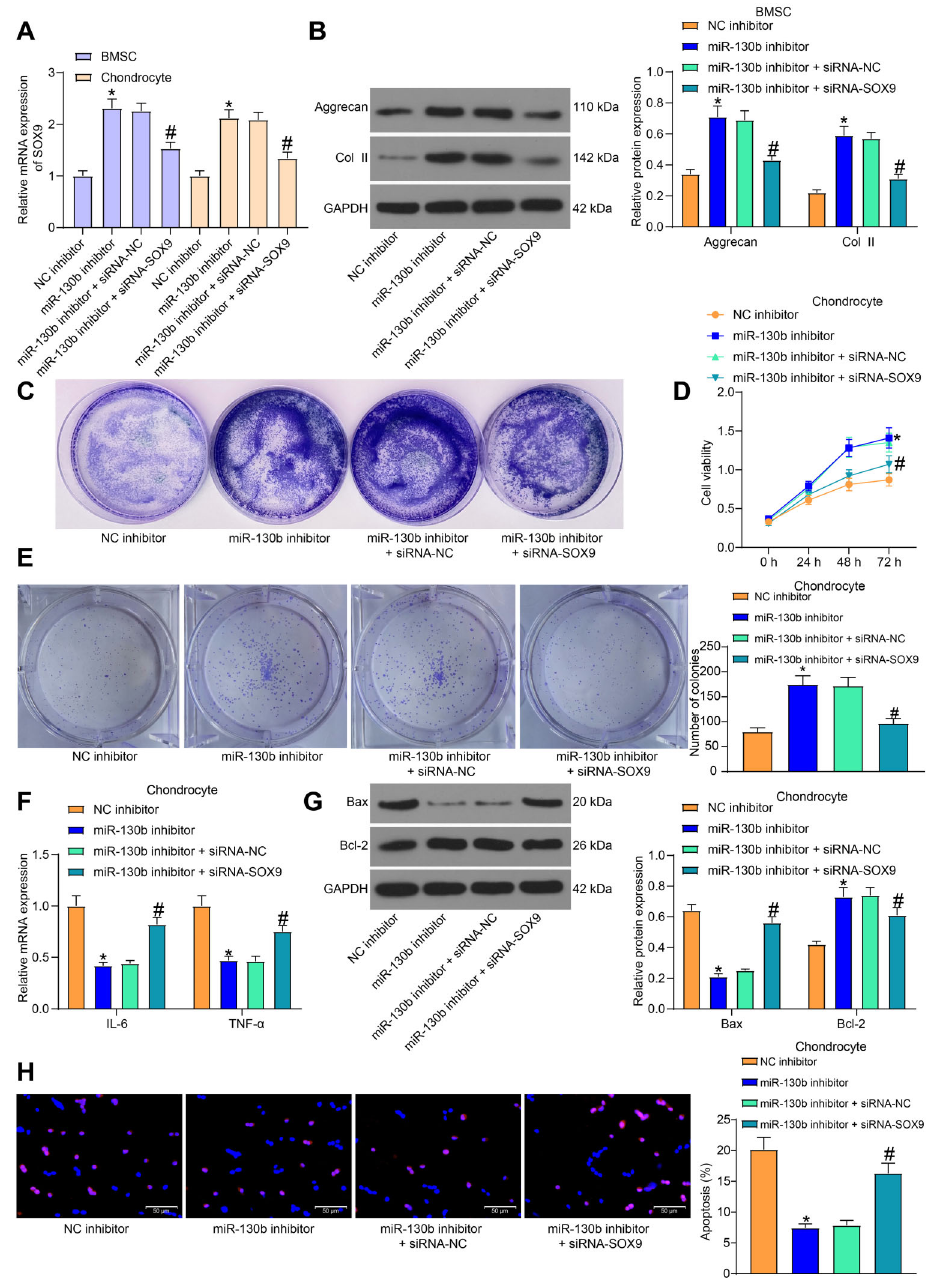
Figure 5. SOX9 silencing weakened the inhibition of miR-130b inhibitor on chondrogenic differentiation of bone marrow mesenchymal stem cells (BMSCs) and chondrocyte growth. A , Expression of SOX9 in BMSCs and chondrocytes was measured by RT-qPCR. B , Western blot analysis measured the protein level of aggrecan and Col II in BMSCs. C , Toluidine blue staining indicated the extracellular matrix synthesis of BMSCs. D , MTT method measured the viability of chondrocytes. E , Colony formation ability of chondrocytes. F , RT-qPCR measured the expression of interleukin (IL)-6 and tumor necrosis factor (TNF)- a in chondrocytes. G , Western blot analysis measured the expression of apoptosis-related factors in chondrocytes. H , TUNEL staining examined the apoptosis rate of chondrocytes (scale bar, 50 m m). The data in panels A, E, and H were analyzed using one-way ANOVA, and the data in panels B, D, F, and G were analyzed using two-way ANOVA. *P o 0.05 compared to cells transfected with NC inhibitor; # P o 0.05 compared to cells transfected with miR-130b inhibitor + siRNA-NC. Experiments were repeated 3 times independently. NC: negative